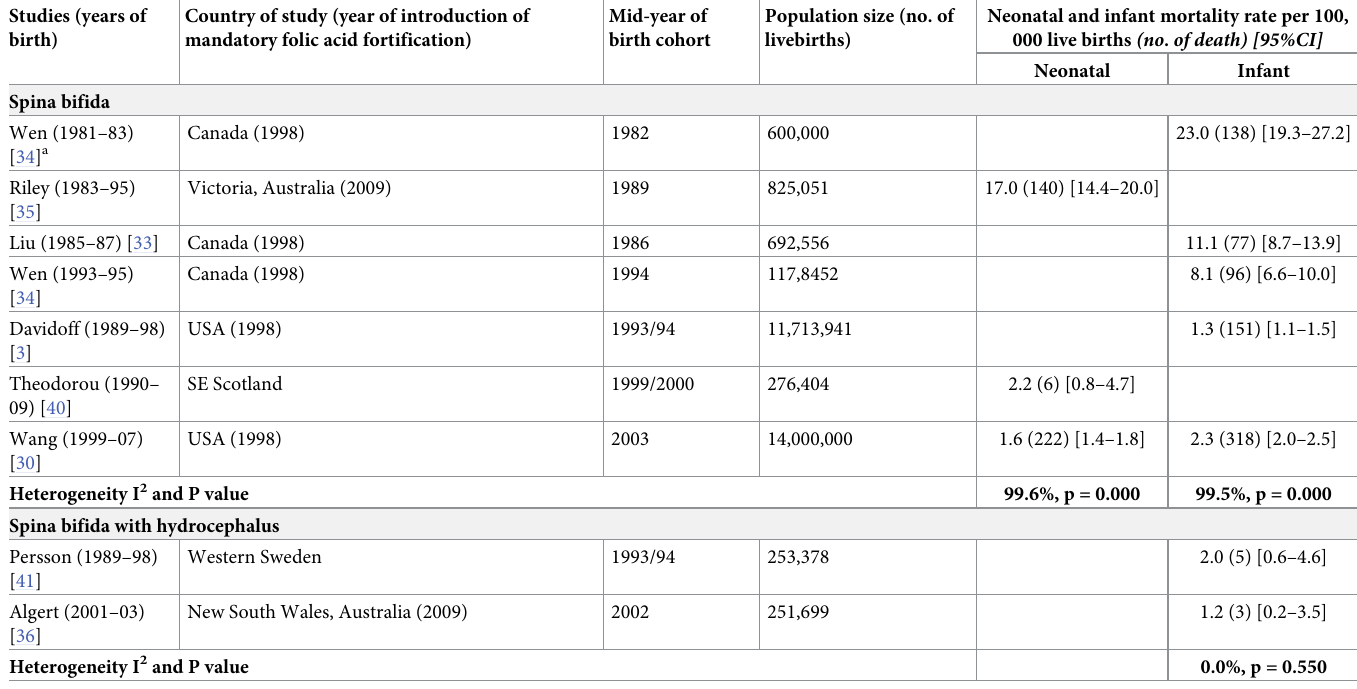
Table 2. Neonatal and infant mortality rates from spina